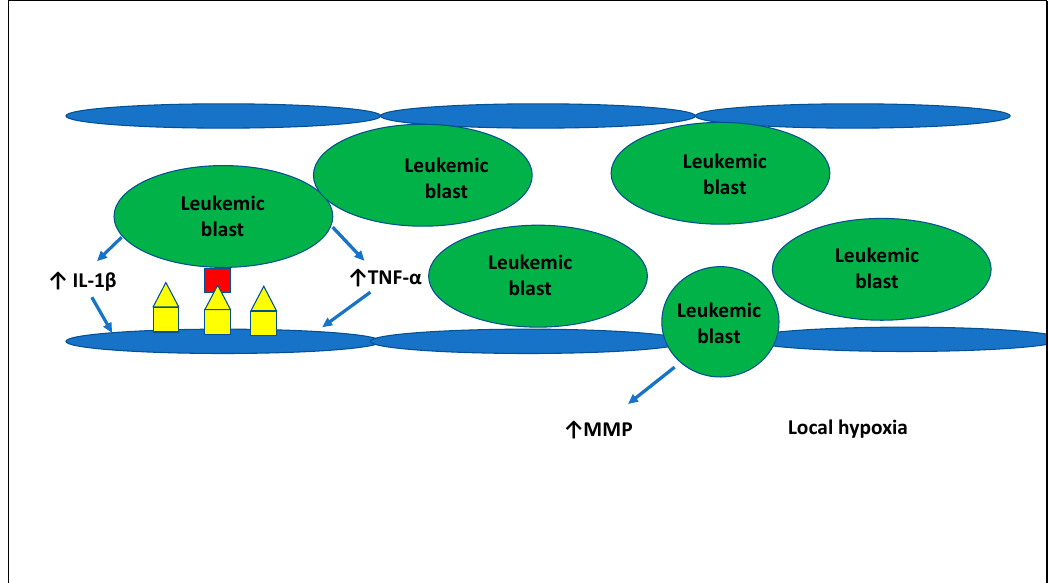
Figure 3. Pathophysiology of leukostasis in AML: Leukostasis in AML is due to various factors. First, myeloblasts are less pliable than mature granulocytes or lymphoblasts and cause mechanical obstruction of small blood vessels leading to hypoperfusion and ischemic damage in distal areas. Second, leukemic blasts produce pro-inflammatory cytokines such as TNF- α or IL-1 β that induce the expression of cell adhesion molecules such as E- / P-selectin, ICAM-1, and VCAM on endothelial cells that interact with adhesion molecules on leukemic blasts (L-selectin, CD43, CD44, P-selectin glycoprotein ligand-1 [PSGL-1]). Third, leukemic blasts release matrix metalloproteinases (MMP) that damage endothelial integrity and enable extravasation of leukemic blasts into tissues and can cause